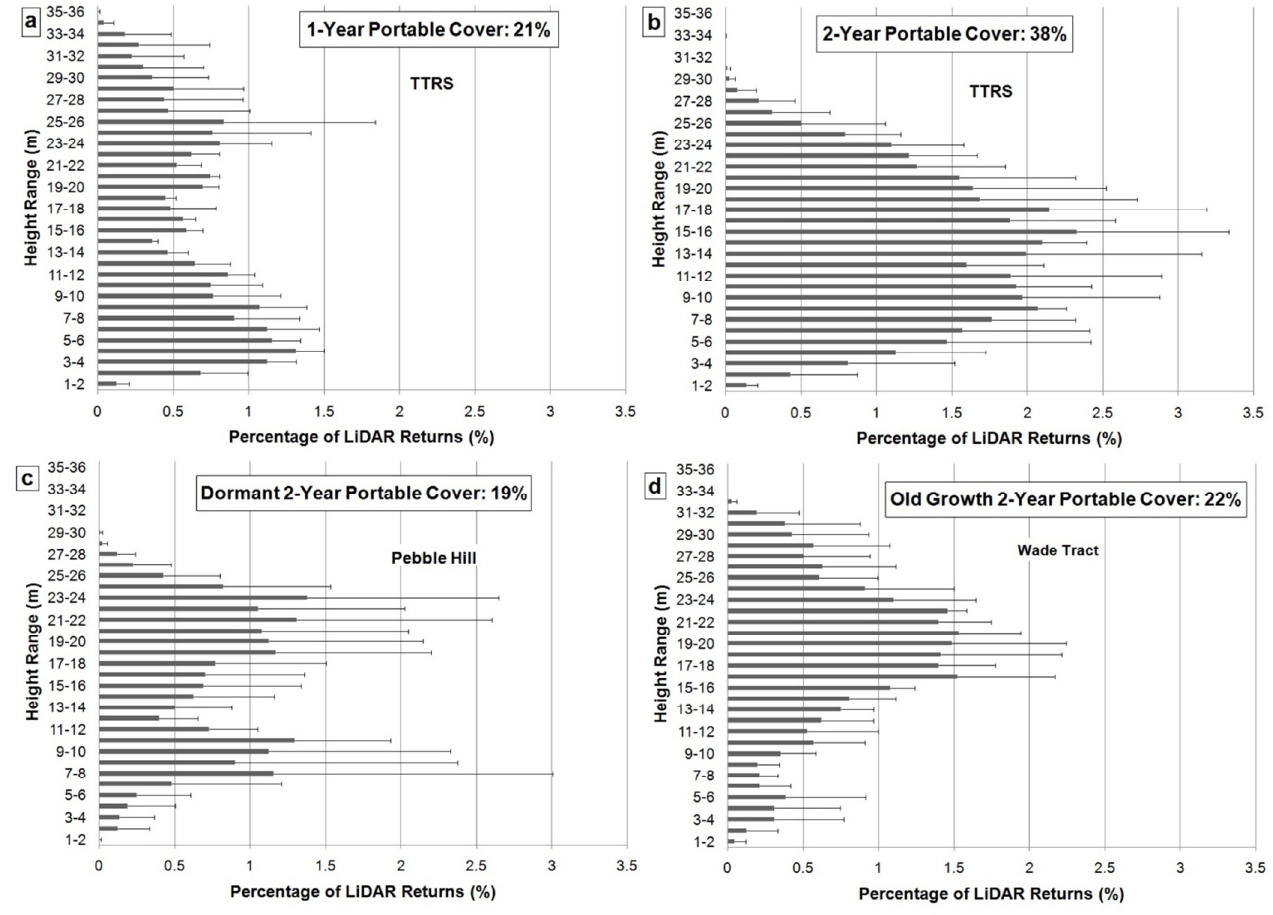
Figure 7. Vertical Distribution of Portable LiDAR returns for Treatment Plots in the Red Hills Area: (a) secondary forest burned in the transitional season with 1-yr fire return interval and (b) 2-yr fire return interval (c) secondary forest burned in the dormant season with a 2-yr fire return interval (d) old growth plot burned in growing season. Errors bars represent the standard deviation of the